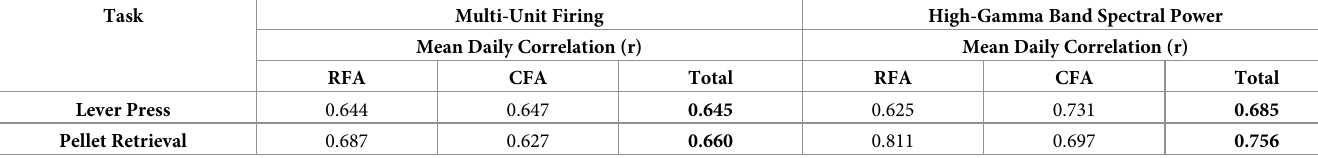
Table 4. Summary of the stability of task-related changes in multi-unit firing rate and high-gamma band power.